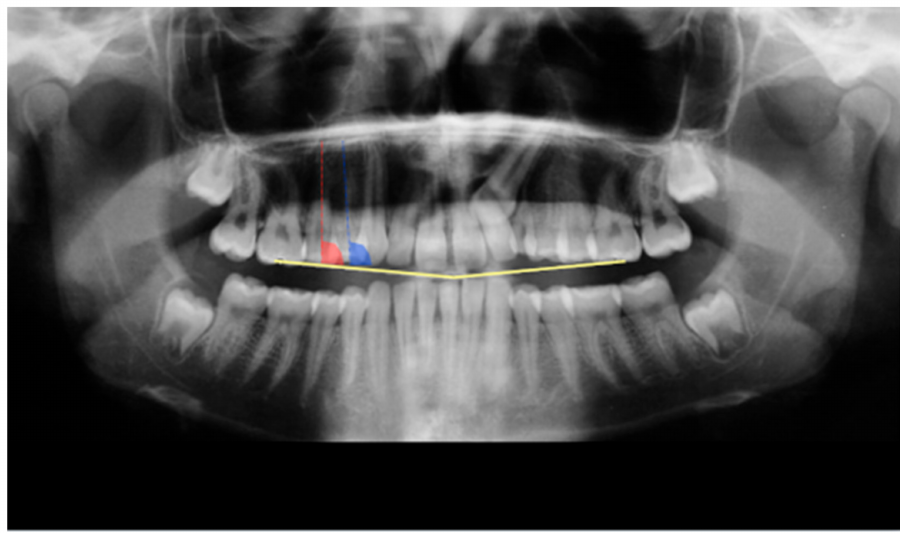
Figure 1. Measurement of mesiodistal angulation on panoramic radiography. The mesiodistal angulation of U4 and U5 was identified by the mesial angle between PO and